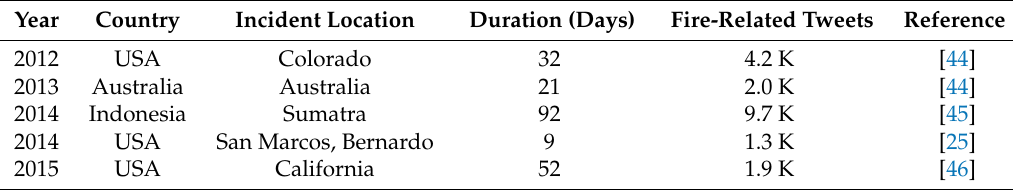
Figure 7. Decision extraction in relation to amount of Tweets retrieved. Table 2. A review of wildfire incidents and related Tweets